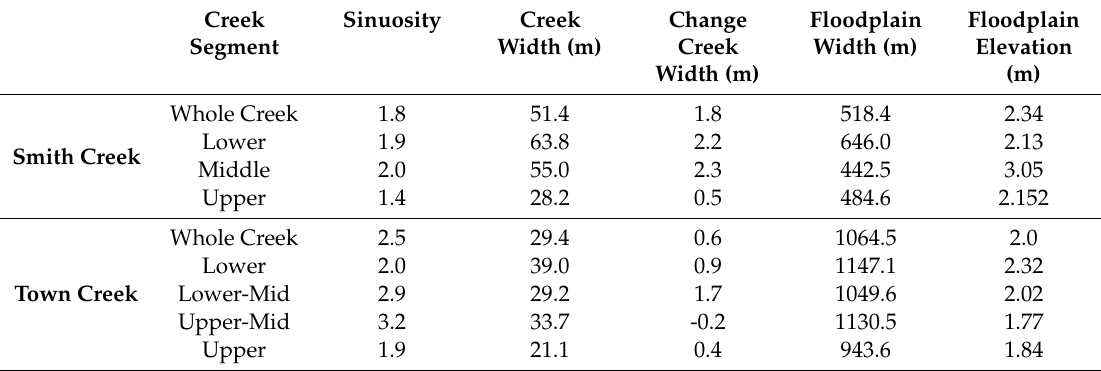
Table 2. Sinuosity, average creek width, average change in creek width through time, average floodplain width, and average floodplain elevation, for Smith Creek and Town